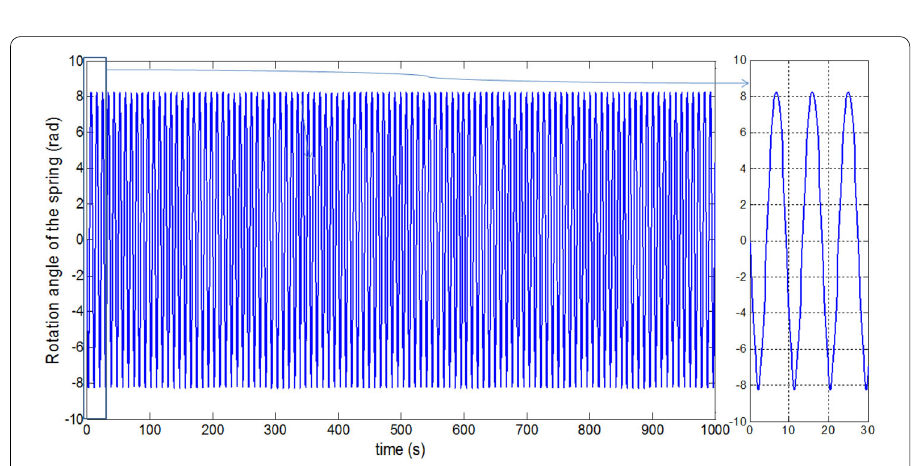
Fig. 16 Spring rotation angle time history